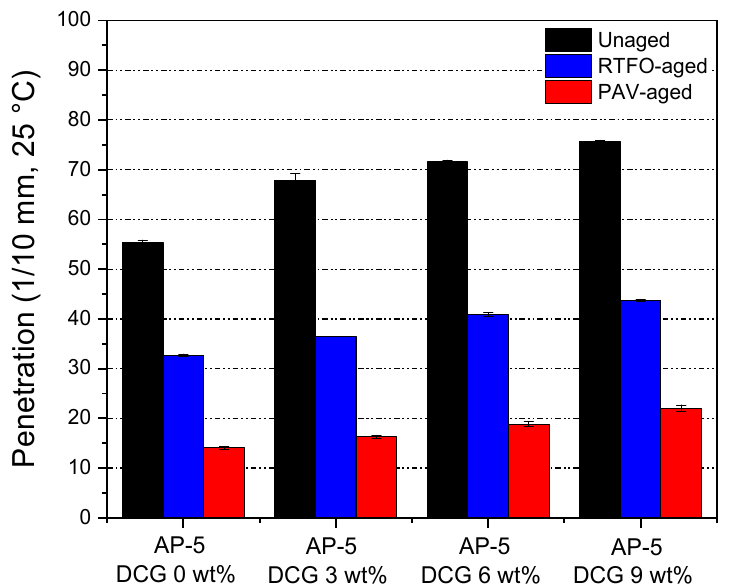
Figure 7. Impact of various dosages of DCG (e.g., 3, 6, 9 wt%) on the penetration of base AP-5 asphalt before and after RTFO and PAV aging.